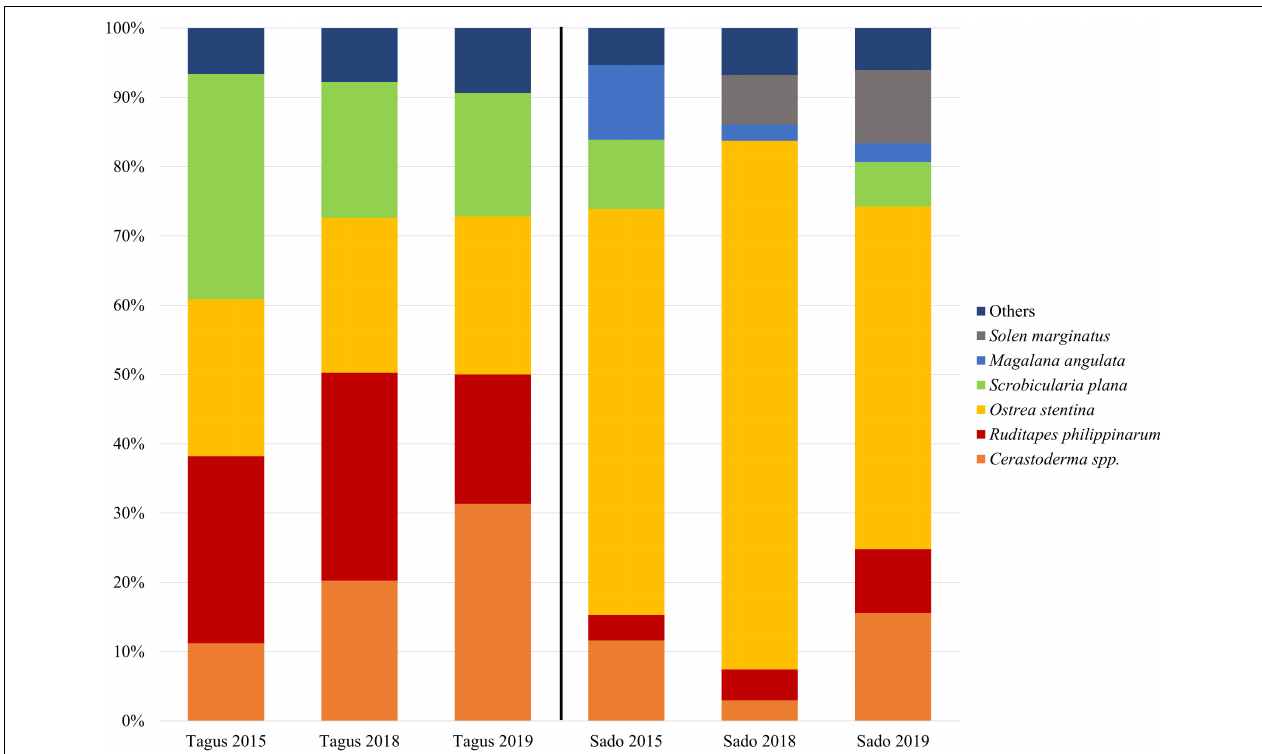
FIGURE 2 | Relative abundance of the most representative bivalve species in the sampling campaigns conducted in the Tagus and Sado estuaries, in 2015, 2018, and 2019.